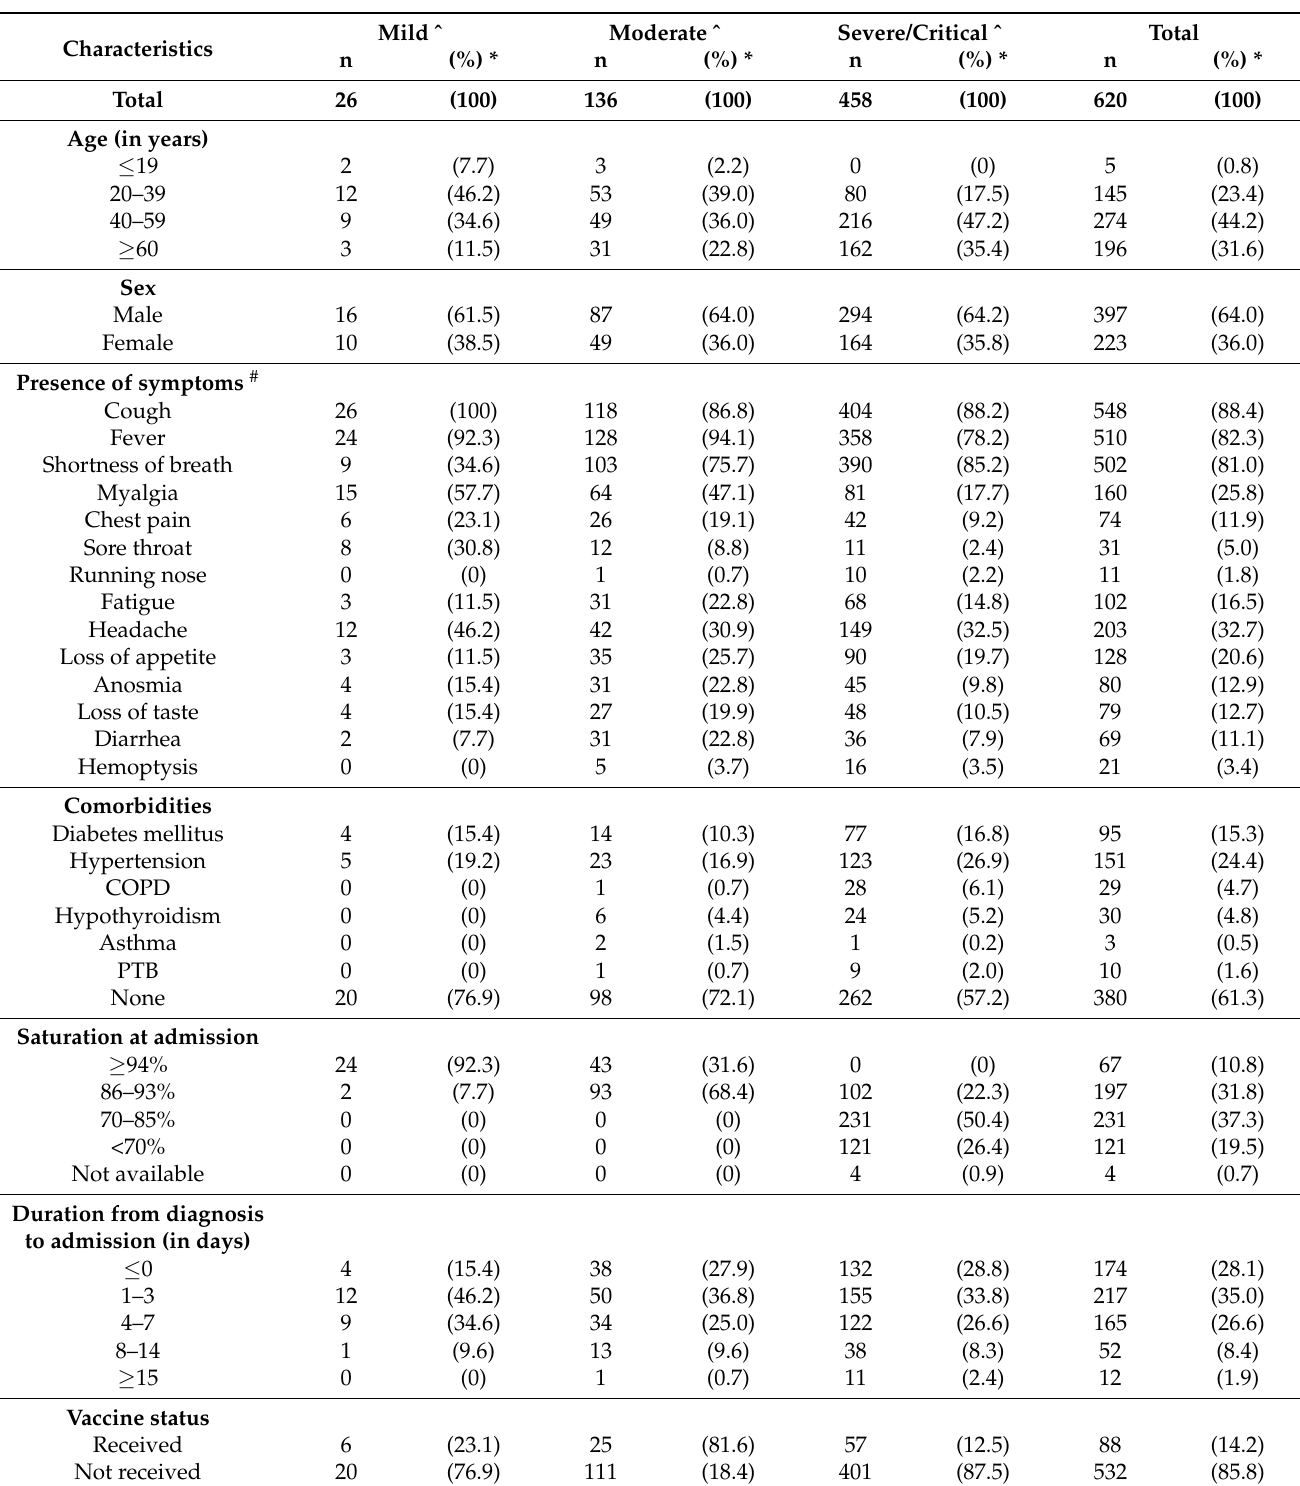
Table 2. Baseline sociodemographic and clinical characteristics of COVID-19 patients (stratified by severity of illness) admitted in a tertiary hospital of Nepal from April to September